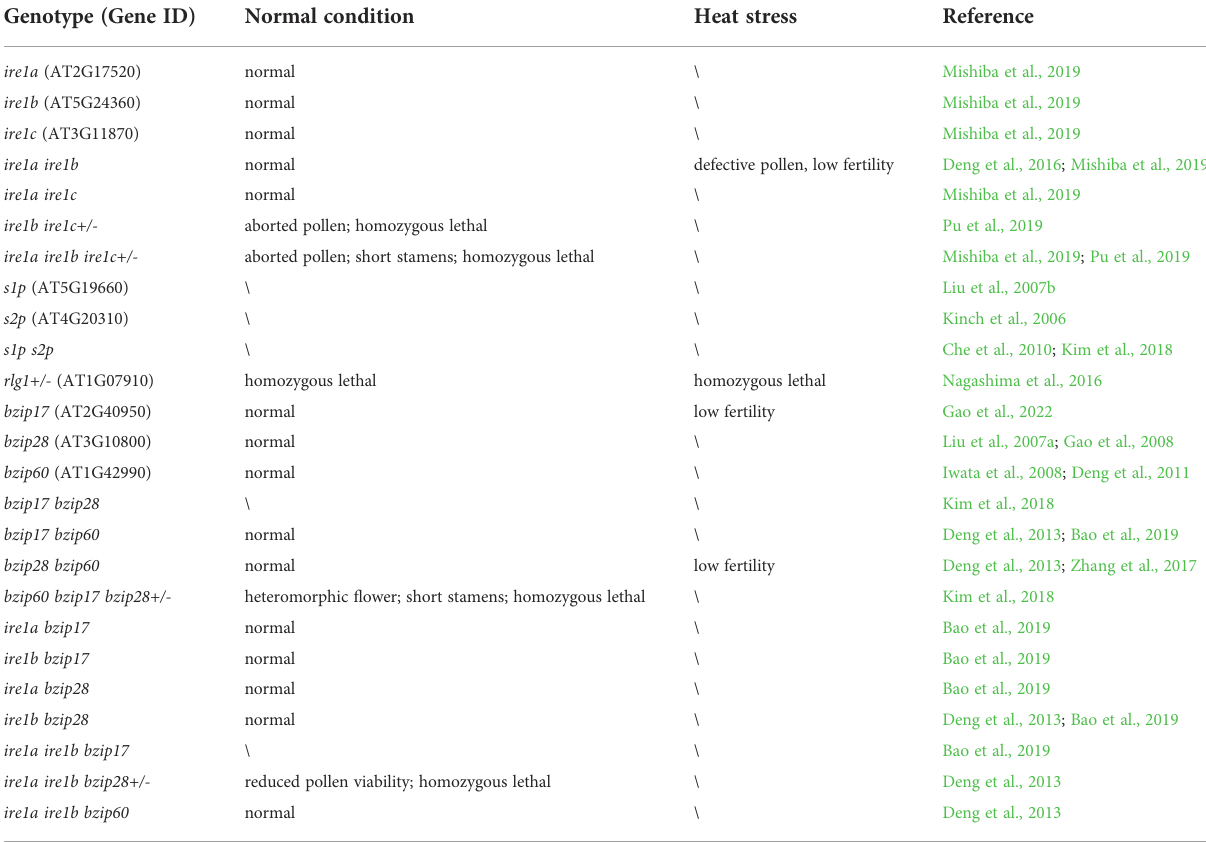
TABLE 1 Reproduction property of Arabidopsis canonical UPR pathway mutants. Genotype (Gene